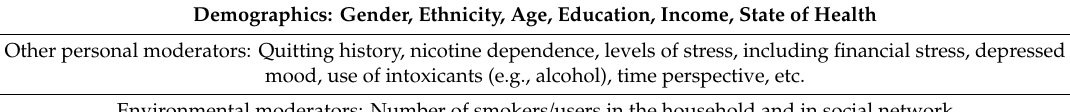
Table 1. International Tobacco Control (ITC) Japan Survey